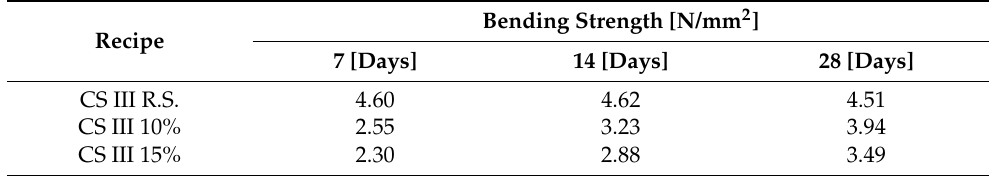
Table 7. Results for bending strength on hardened mortars.